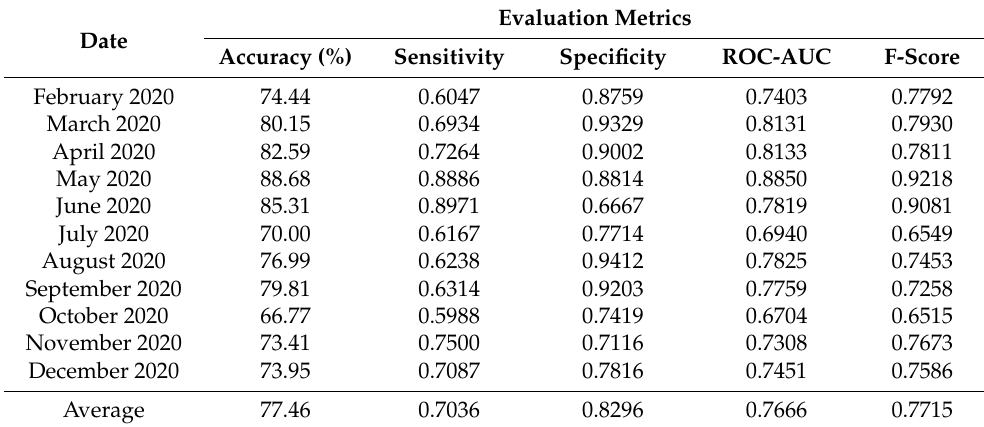
Table 2. Evaluation of dynamic predicting